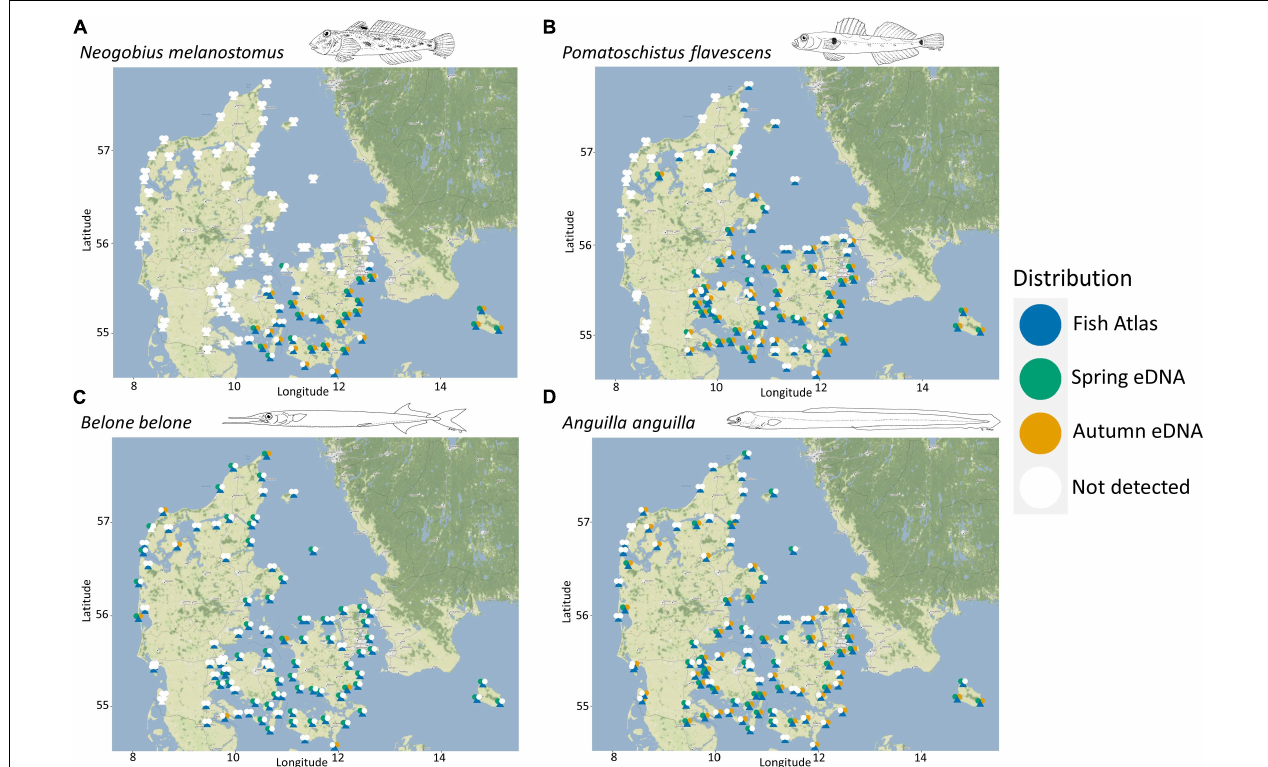
FIGURE 3 | Species distribution examples representing: (A) round goby ( Neogobius melanostomus ), an invasive species with an eastern distribution and an ongoing western expansion, (B) two-spotted goby ( Pomatoschistus flavescens ), a species with a restricted distribution (i.e., not found on the west coast of Jutland), (C) garfish ( Belone belone ), the species with the strongest seasonally diverging signal in occurrence, (D) European eel ( Anguilla anguilla ), an endangered species with a wide distribution. Detections with eDNA during spring (bluish green) or autumn (vermilion) are represented by the “left” and “right” circle, respectively. Registrations by the Fish Atlas (blue) are represented by triangles. White colored triangles or “left” and “right” circles indicate that the species is not detected on the location for the particular dataset. All fish drawings have been made by Steen Wilhelm